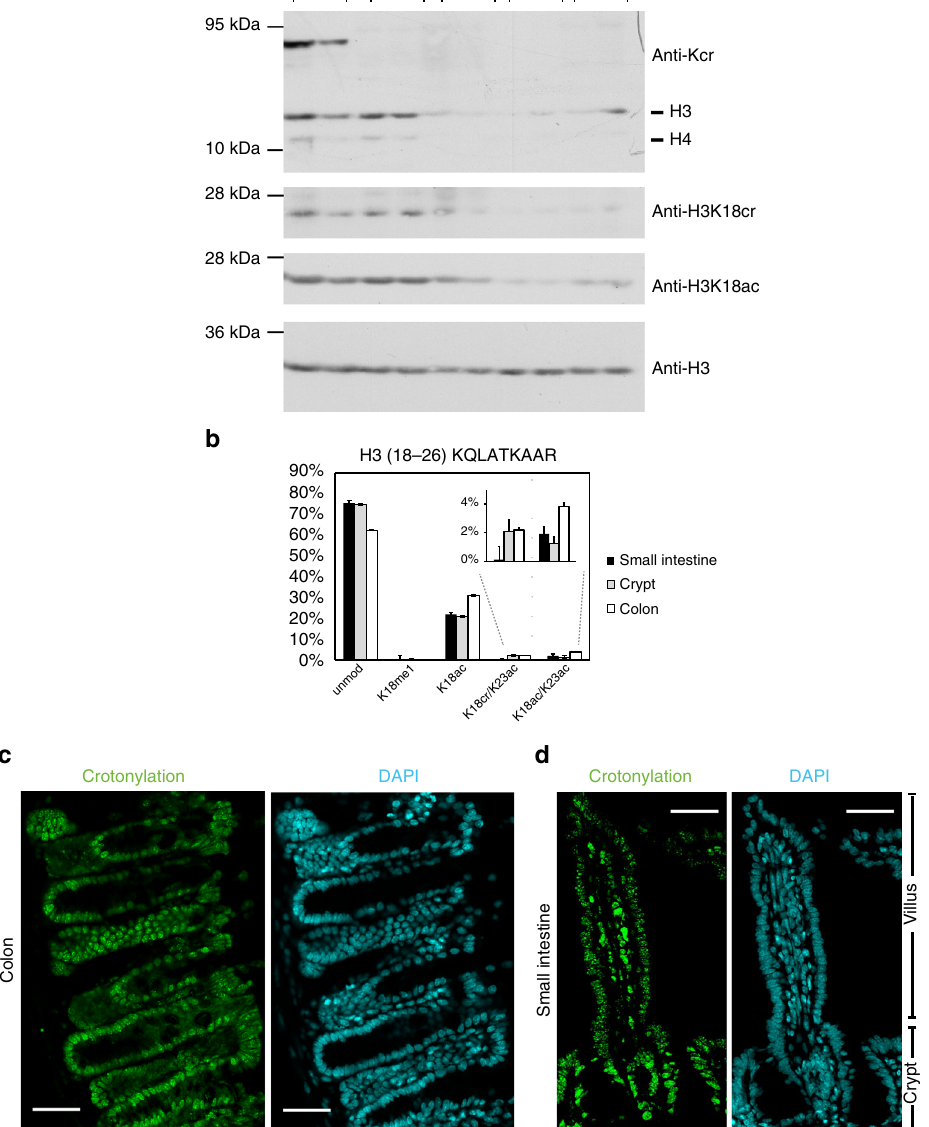
Fig. 1 Histone crotonylation is found in the intestine. a Western blot analysis of whole cell extracts from several mouse tissues using indicated antibodies shows that histone crotonylation is particularly abundant in the brain and colon; the analysis of tissues from two mice is shown. b Relative abundance of H3K18cr in the intestinal epithelium cell fractions, n = 3, error bars are standard deviation. c , d Immuno fl uorescence microscopy with anti-pan crotonyl antibody (green, left panels) and DAPI counterstaining (cyan, right panels) of a mouse colon ( c ) and small intestinal ( d ) tissue sections, scale bars 40 μ